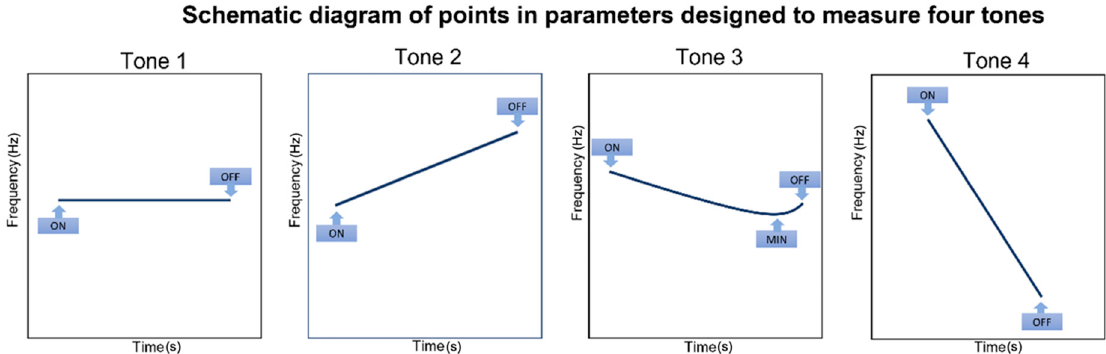
Figure 1. Schematic diagram of points in parameters designed to measure four tones. Each panel shows F0 as a function of normalized time. The blue lines from left to right refer to F0 from Tone 1 to Tone 4. Point ON is the onset point of voice, point OFF is the offset point, and point MIN has minimal tone frequency.